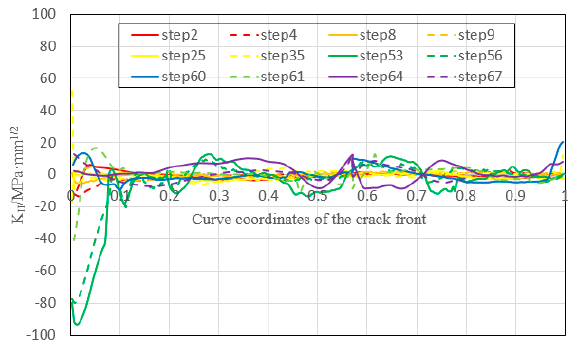
Figure 18. K II evolution of characteristic points ( K equ + SERR).